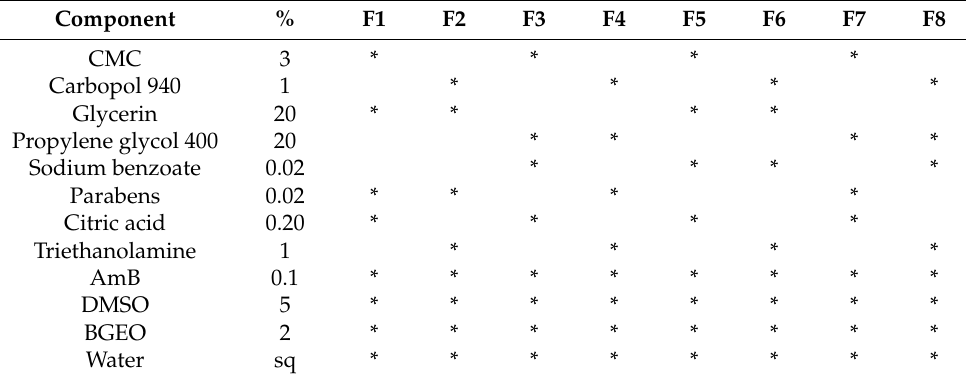
Table 6. Formulations developed from the 2 3 factorial